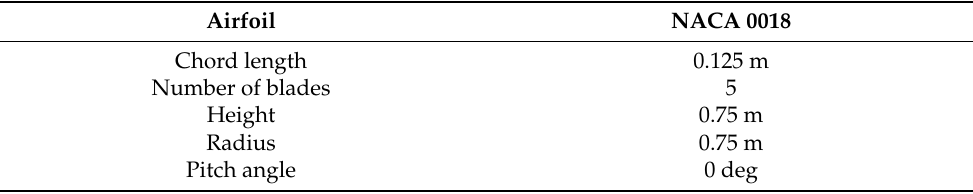
Table 2. Final selected design parameters for the vertical axis water turbine.